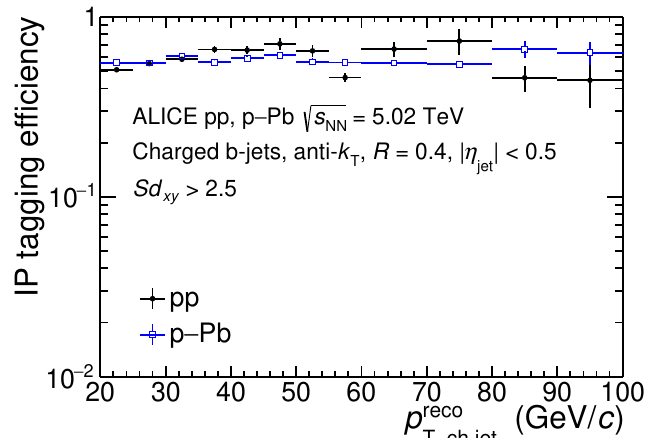
Figure 6. The b-jet tagging efficiency extracted from the data-driven method using the IP algo- rithm in pp and p-Pb